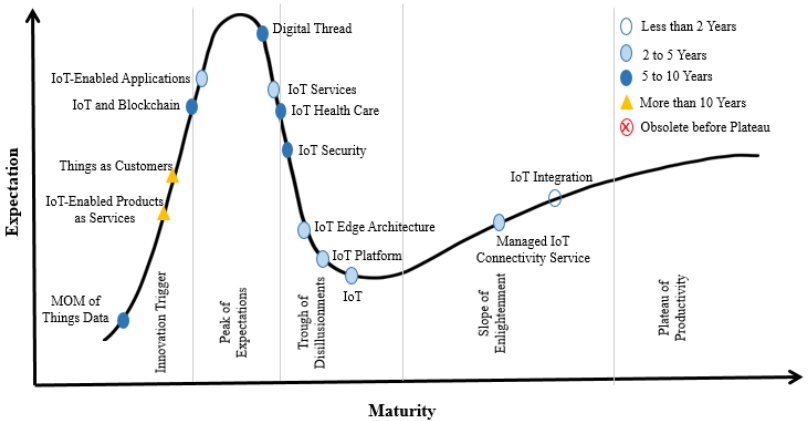
Fig. 2. Gartner hype cycle of various IoT technologies, as of